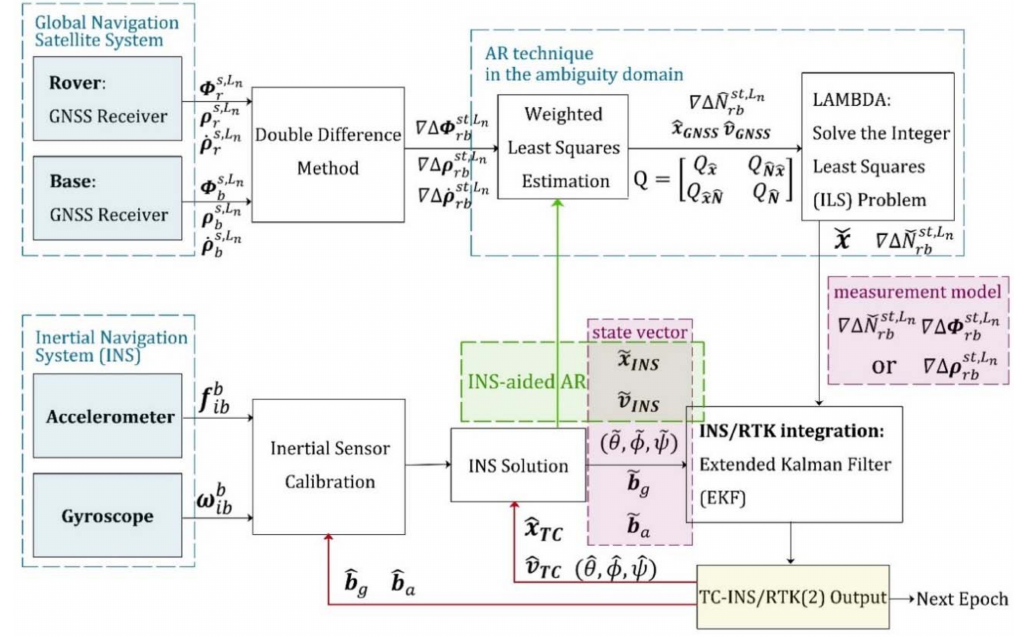
Figure 2. The second implementation of tightly-coupled INS/RTK integration using